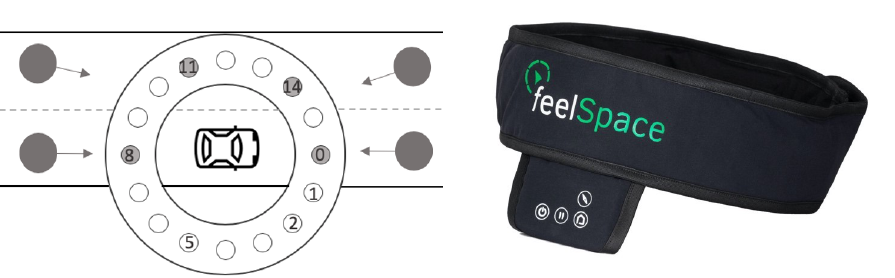
Figure 2. ( Left ) Schematic of the belt in an example situation where from every left and center lane direction an object (large gray dot) is approaching with a time to collision (TTC) value under nine seconds. Vibromotors nr. 0, 14, 8 and 11 (small grey dots) would activate in this case. If the ego-vehicle drove on the left lane, the activations would occur at vibromotor 0, 2, 5 and 8. Note that the selected vibromotors on the rear were spaced two instead of one gap apart to account for differences in spatial discriminability between dorsal and ventral regions [47,57]. ( Right ) Photograph of the tactile waist belt ( c (cid:13) feelSpace